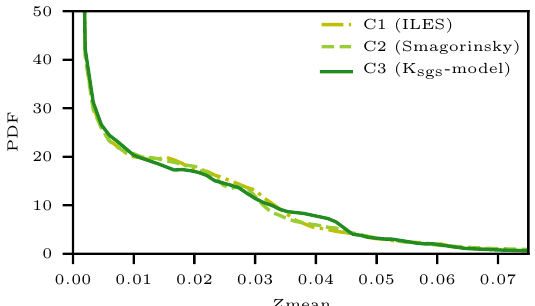
Figure 12. PDF of mean mixture fraction for the spray region averaged over the interval 1.5–2.0 ms. Spray region is conditioned by Z > 10 − 5